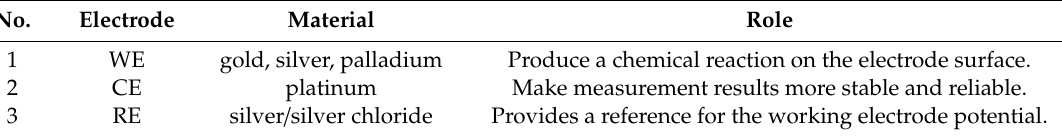
Table 1. The details of the electrode sensor